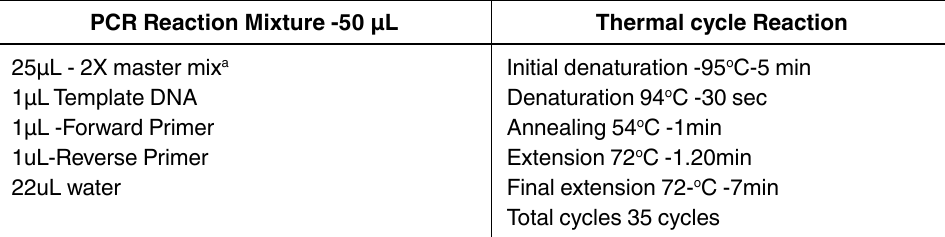
table 2. Details of PCR reaction setup and Thermal cycle reaction